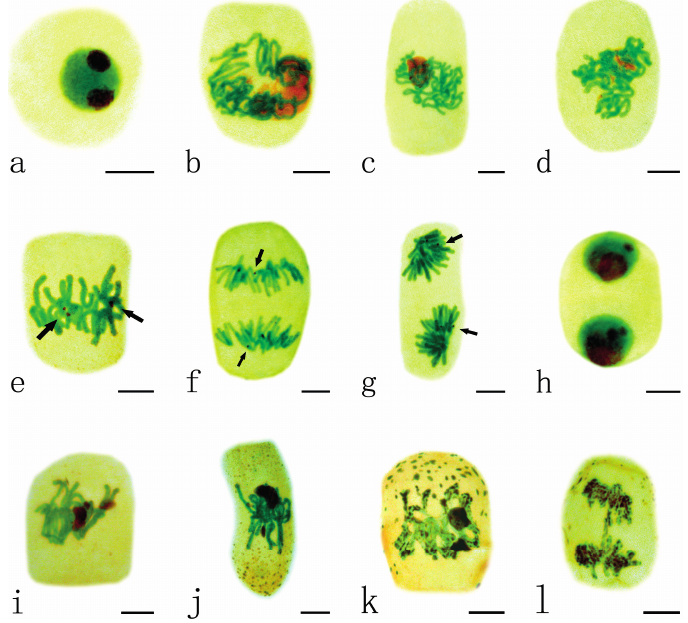
Figure 2. Effects of different concentrations of Pb on nucleolar organizing regions (NORs) in root tip meristematic cells of A. cepa during mitosis. ( a – h ) Normal mitotic process. ( a ) The interphase cell; ( b , c ) Showing decondensed chromatin fibers were around the nucleoli; ( d ) Showing that the nucleoli disappeared in their characteristic structures; ( e ) Showing NORs localized on metaphase chromosomes; ( f ) Showing NORs migrated with the chromosomes to the poles at anaphase; ( g ) Showing nucleoli rebuilt at early telophase and the size increased; ( h ) Showing the two daughter nuclei entered interphase, and mitosis was completed; ( i – l ) Mitotic process under Pb stress. ( i , j ) Showing persistent nucleoli during metaphase (( i ) 10 μ M Pb, 24 h; ( j ) 1 μ M Pb, 48 h); ( k ) Showing sticky chromosomes with Ag-stained NOR particles at metaphase (100 μ M Pb, 48 h); and ( l ) Showing sticky chromosomes with Ag-stained NOR particles at anaphase (100 μ M Pb, 48 h). Scale bars = 10 μ m. Nucleoli and NORs: dark brown; nuclei and chromosomes: green; cytoplasm: yellow. Arrowhead shows